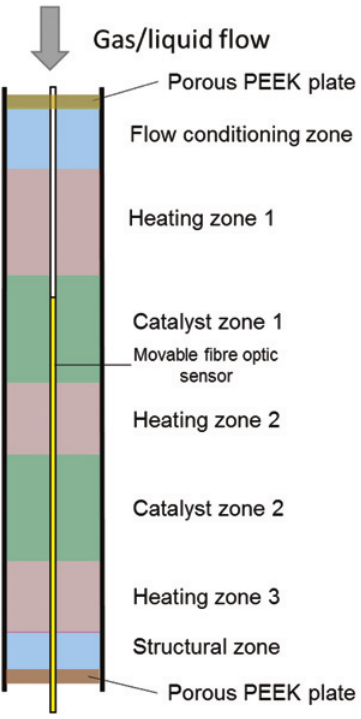
Figure 1: The schematic representation of the reactor showing heating and catalytic